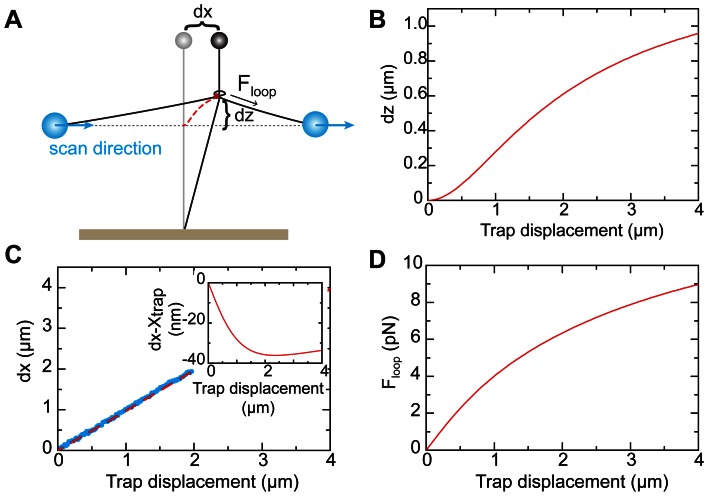
Calculated position and forces acting on the scanning DNA loop.(A) schematic diagram, not to scale, showing the displacement of the DNA loop as the optically trapped beads are scanned to the right. Forces and positions were calculated iteratively for a 48 kb DNA molecule, at an initial loop height of 2 µm above the surface, initial tensions were 10 pN for both DNA molecules, and optical trap stiffness was set to 100 pN/µm. The elasticity of the DNA was modeled by the worm-like-chain model. As the loop encounters a bound protein or other obstacle during the scan, the DNA will no longer slide through the loop but displace the magnetic bead by dx. Due to the direction of forces acting on the loop it will move to the right and upward following the track depicted by the red dotted line. (B) Calculated upward movement, dz, of the loop as a function of trap displacement after encountering a protein. (C) Movement of the magnetic bead in the scan direction after the loop encounters a bound protein (blue points experimental data, red dashed line calculation). The displacement of the magnetic bead is almost equal to that of the scanning traps, inset shows the difference between the magnetic bead position, dx, and trap position, Xtrap; note the nm scale. (D) Calculated force acting on a protein blocking the DNA loop.